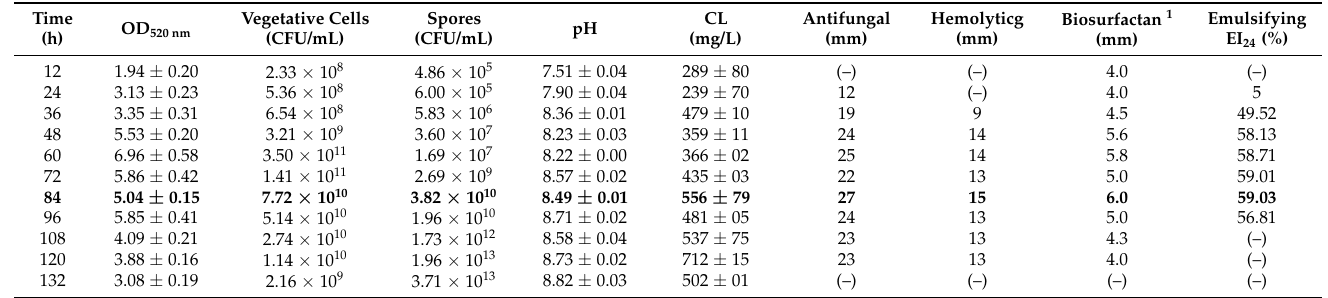
Figure 3. Retention factor in thin layer chromatography (TLC) analysis of the crude lipopeptide extract CL 84 . ( a ) revealed with ninhydrin and cupric sulfate. ( b ) Bioautography against C. gloeospor- ioides growth in an agar overlay and dyed with an aqueous solution of 2,3,5 triphenyltetrazolium chloride and ( c ) in blood agar overlay.